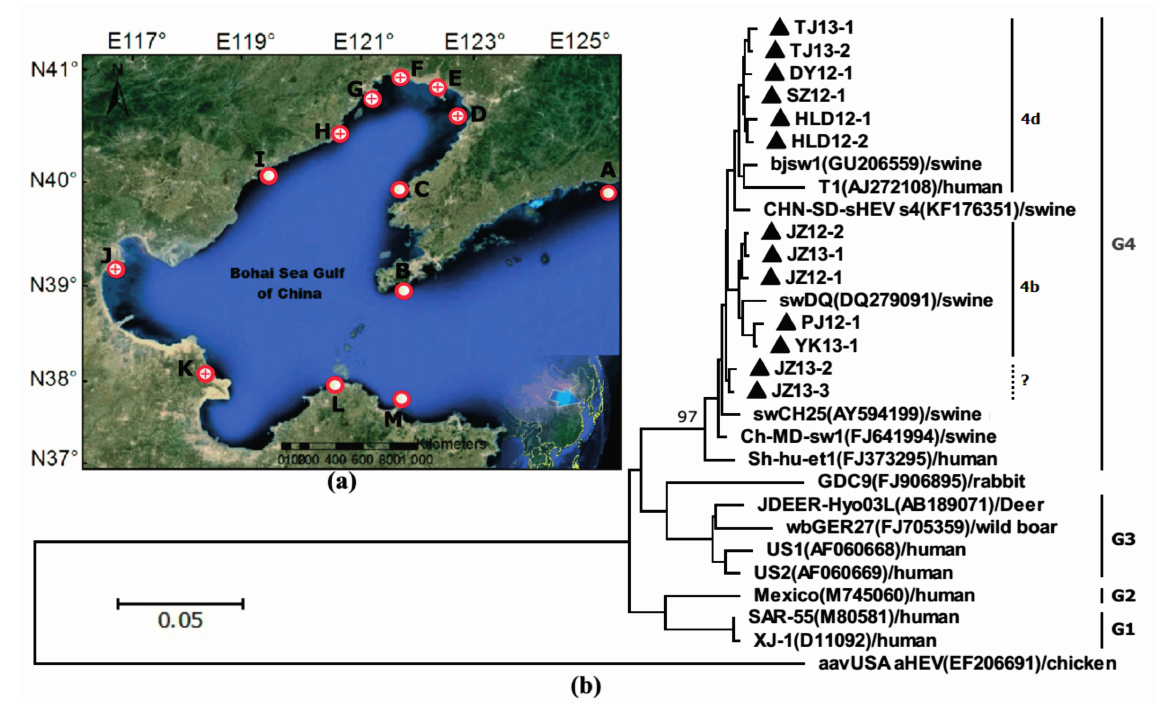
Figure 1. Locations of shellfish sampling and phylogenetic trees of hepatitis E virus. ( a ) Locations of shellfish collected in the Bohai gulf rim. The site of HEV RNA positive detection is marked by a positive sign within red circle and that of negative detection’s with a only a red circle . ( b ) Phylogenetic trees of hepatitis E virus (HEV) were